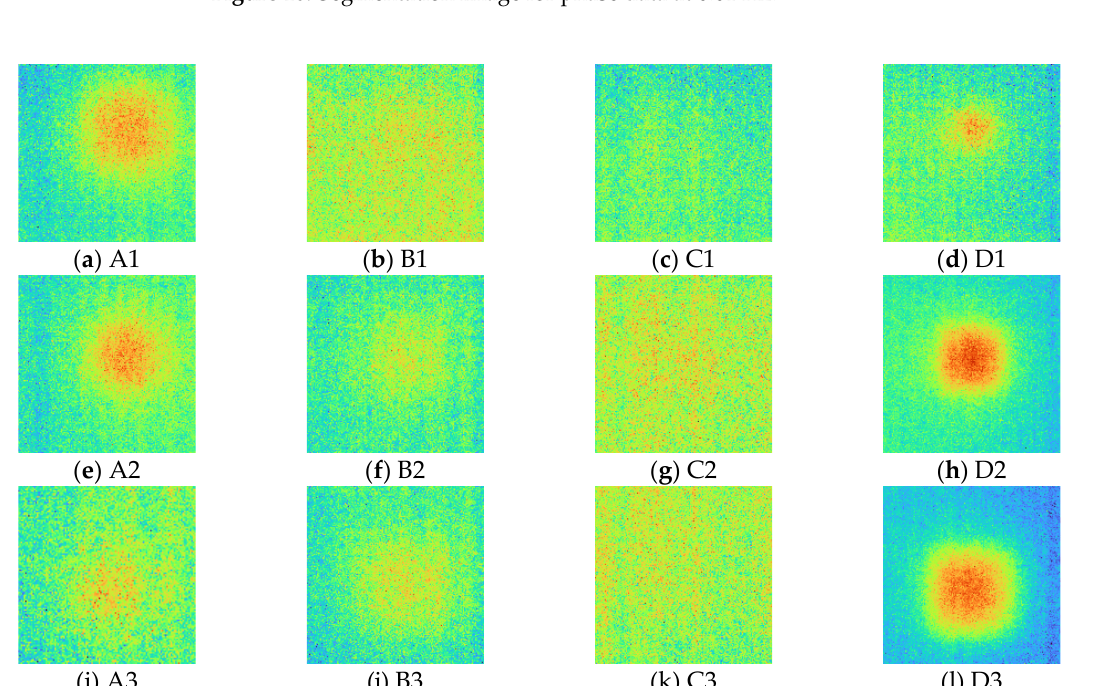
Figure 11. Segmentation image for amplitude data at 0.09 Hz.